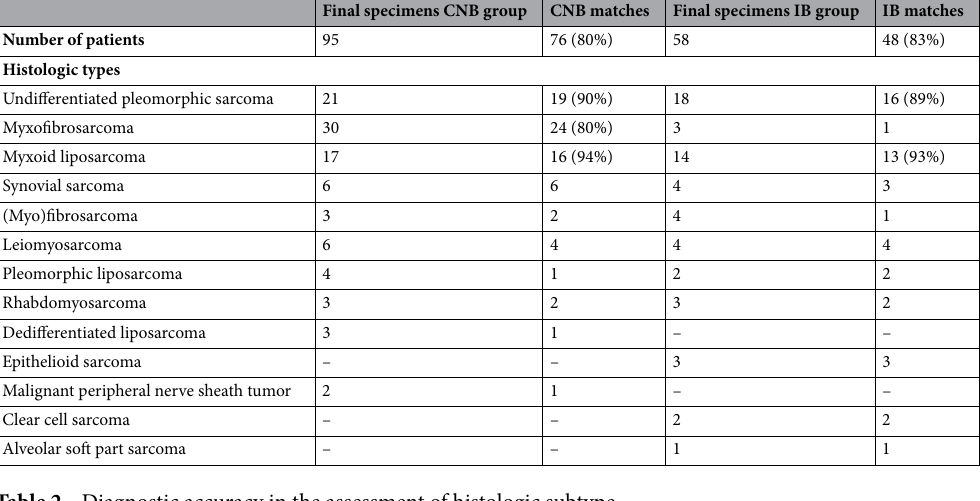
Table 2. Diagnostic accuracy in the assessment of histologic